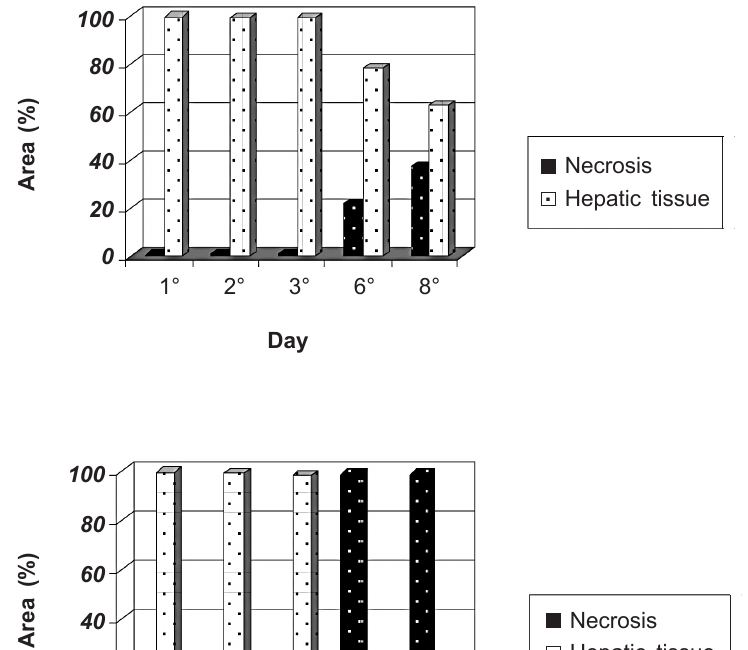
Fig. 3. – Area of necrosis and of normal hepatic tissue in hamsters (n = 5 per group) inoculated with E. histolytica .